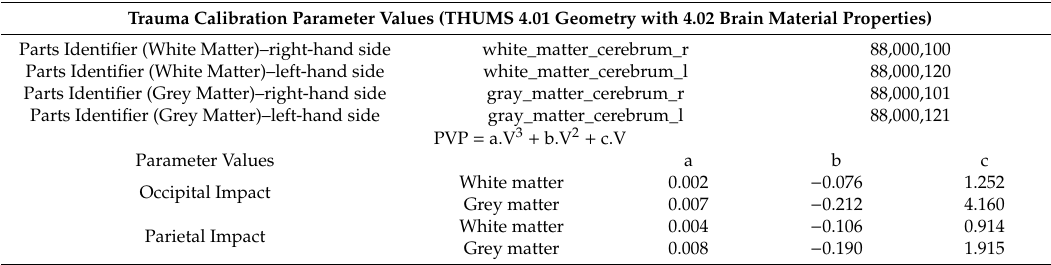
Table 4. AIS interpolation equation [41].